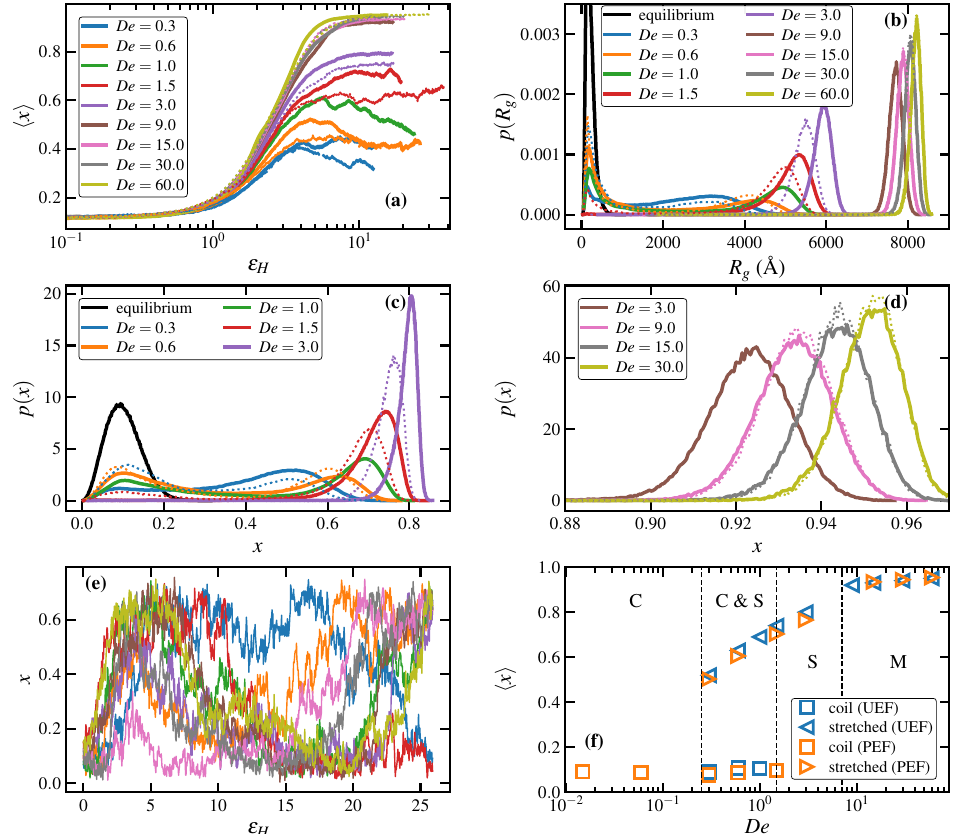
x Figure 1. ( a ) Mean fractional extension, , as a function of Hencky strain, ε H , for startup of (cid:104) (cid:105) elongational flow at various values of De : solid lines correspond to UEF and dotted lines to PEF. ( b ) Steady-state probability distribution functions, p ( R g ) , of the molecular radius of gyration, R g , at various values of De in both UEF and PEF. Panels ( c , d ) display steady-state probability distribution functions, p ( x ) , of the fractional extension at various values of De ; ( c ) displays p ( x ) at lower De whereas ( d ) presents p ( x ) at high De where FIC was observed. ( e ) Fractional extension vs. ε H for several selected individual chains undergoing startup of UEF at De = 0.6 depicting the gradual transitioning of molecules between coiled and stretched configurations. ( f ) Steady-state mean frac- tional extension versus De for UEF and PEF; blue symbols denote UEF data and orange symbols denote data taken from PEF simulations. Vertical dashed lines delineate approximate boundaries of various configurational states or phases: C, S, and M denote coiled liquid, stretched liquid, and predominantly monoclinic semicrystalline states,